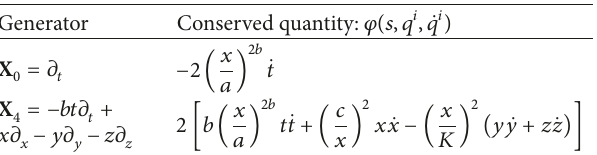
Table 38: Conserved quantities corresponding to each Noether